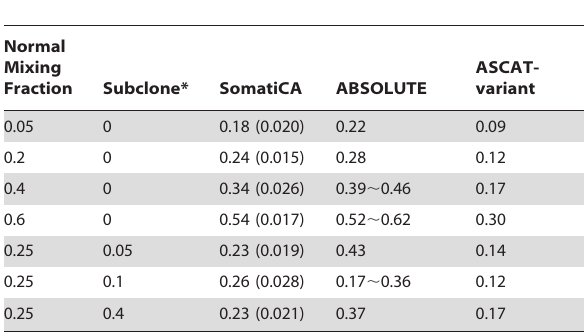
Table 1. Admixture Rate Estimation for the TCGA benchmark